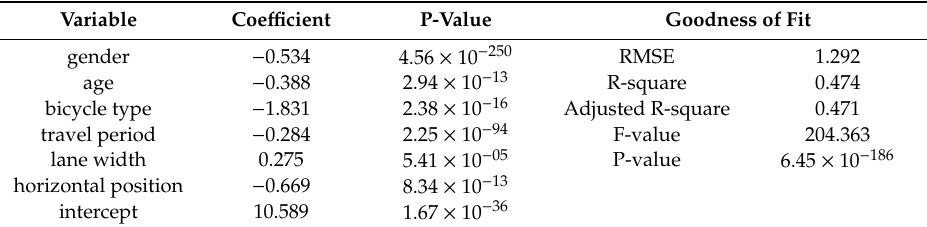
Table 4. Results of Parameter Estimating and Goodness of Fit for Generalized Linear